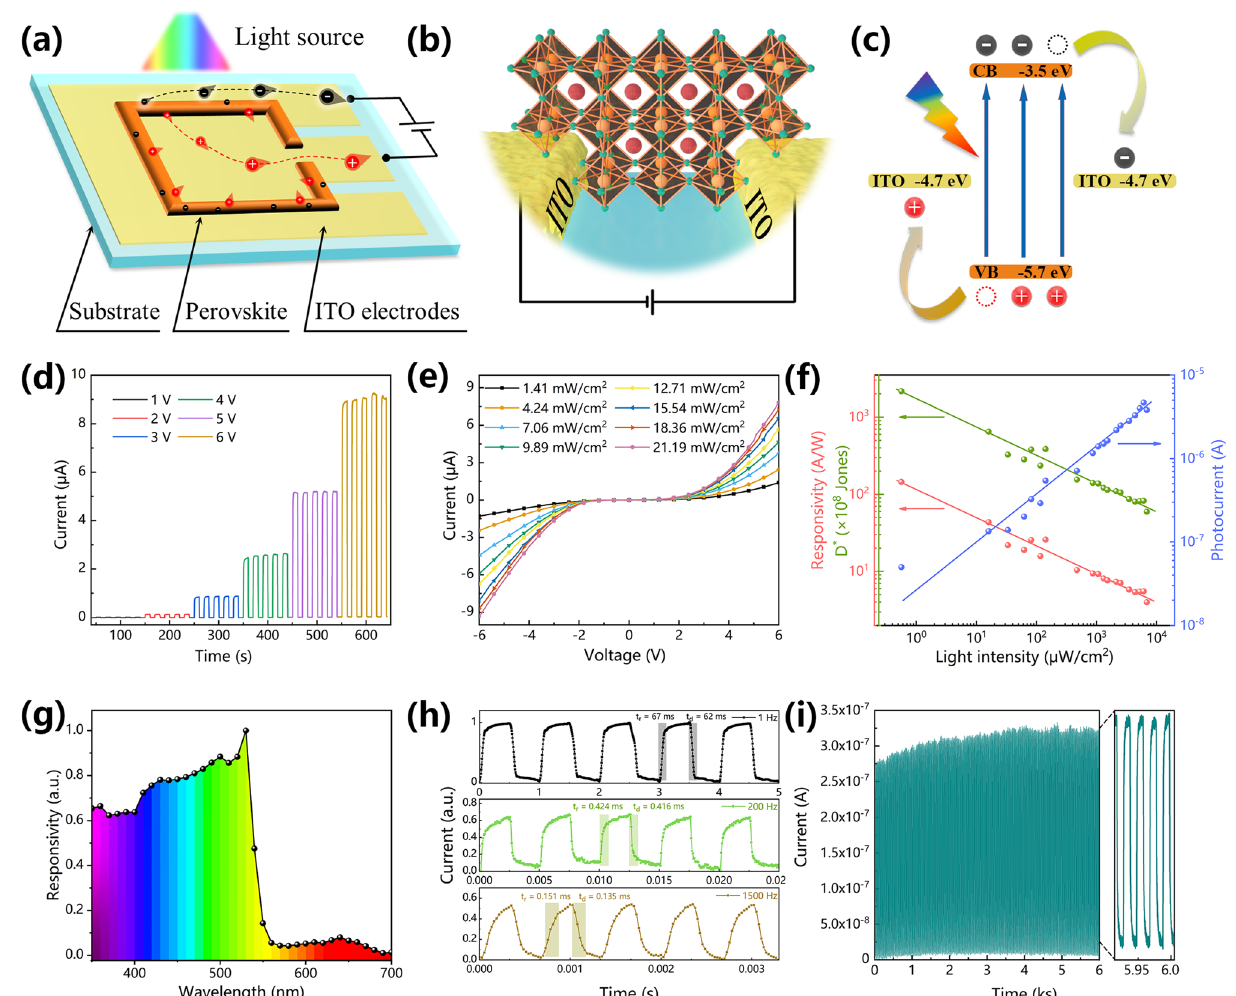
Fig. 4 Photodetection performance of individual perovskite photodetector on a glass substrate. a Schematic diagram of the lateral structure and working mechanism of an SRP. b Schematic diagram of partial enlargement of SRP. c The energy-band alignment of SPR. d Current–time (I–t) curves of the perovskite photodetector under different bias voltages when irradiated with a 450 nm pulsed light source. e I-V curves of the pho- todetector under the irradiation of a 450 nm light source at different light powers. f Dependence of the responsivity, the D* and the photocurrent on the light intensity at the 520 nm. g A normalized responsivity curve of the photodetector under different illumination wavelengths (350 – 700 nm). h I-t curves at a 6 V bias and different on/off frequencies of 520 nm light sources. i On/off switching stability test of the device at a 3 V bias and 520 nm pulsed light source at a frequency of 0.05